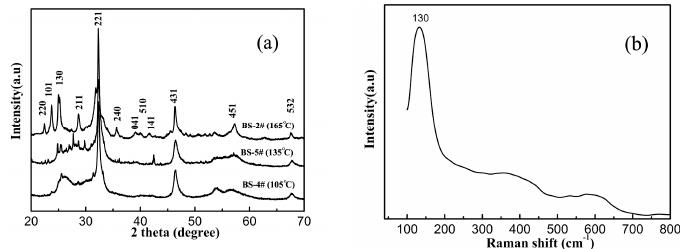
Figure 1. ( a ) XRD patterns of 3D hierarchical Bi 2 S 3 architectures prepared at different hydrothermal temperatures; and ( b ) the Raman spectrum of the representative 3D hierarchical Bi 2 S 3 architectures (BS-2#).